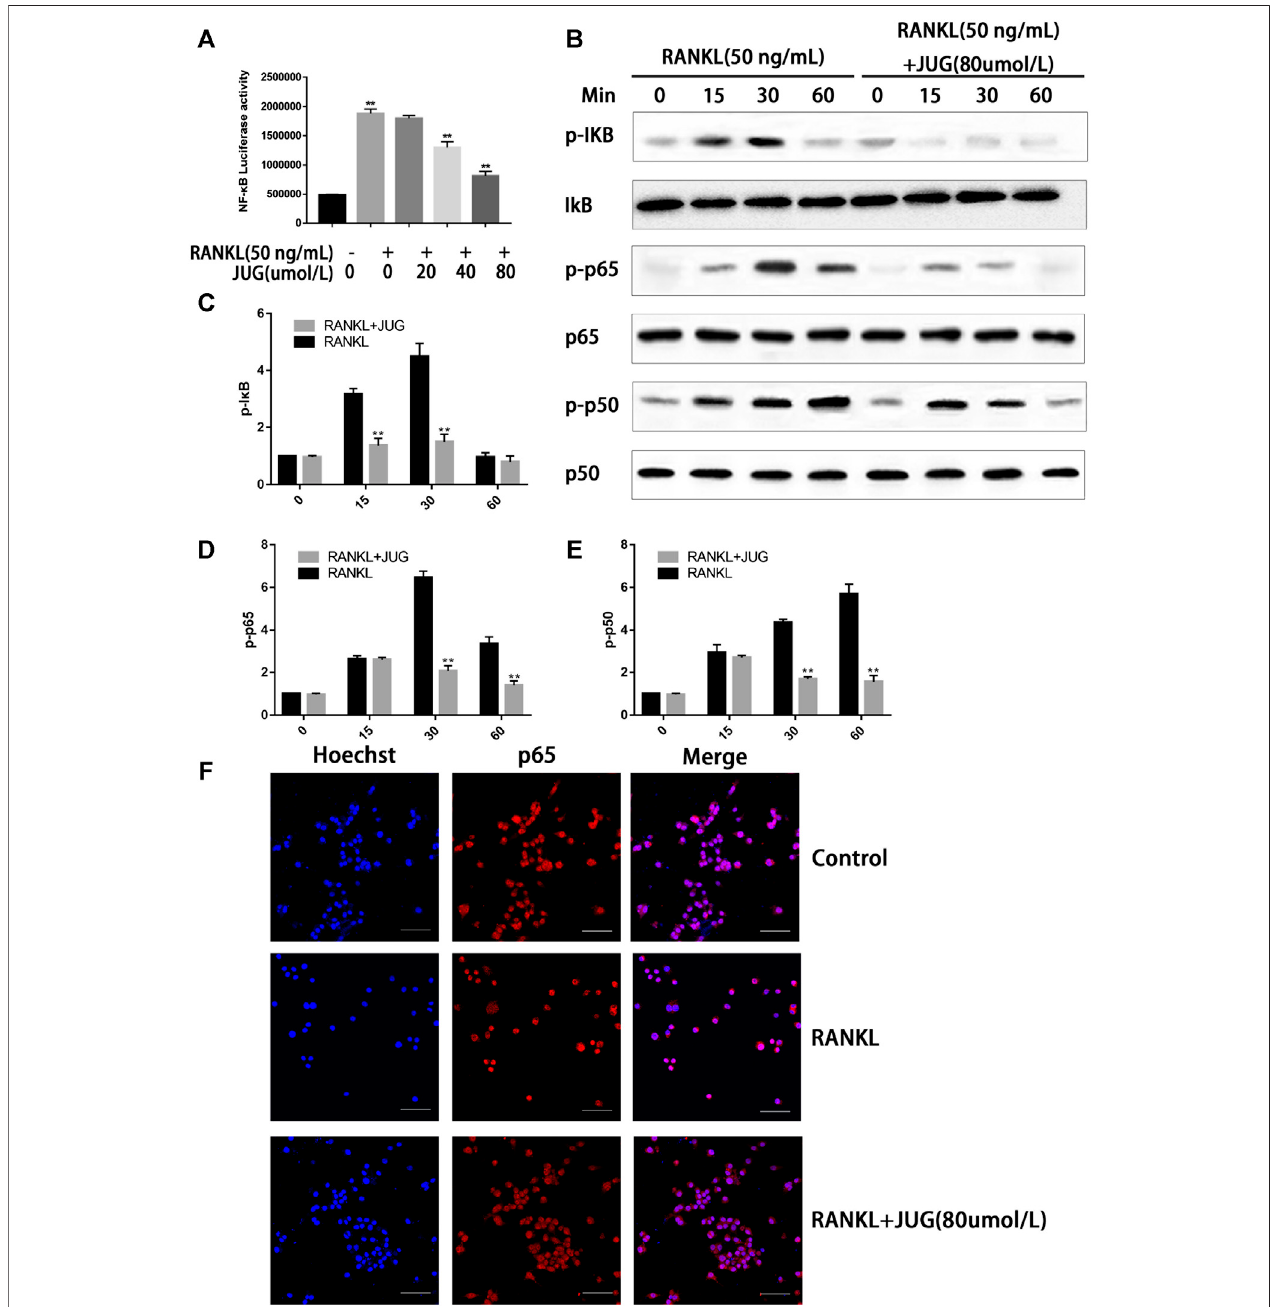
FIGURE 6 | JUG suppresses the NF- κ B signaling pathway. The ratio of the fl uorescence intensity was quanti fi ed by ImageJ software (A) luciferase reporter gene assay showing that JUG suppresses the RANKL-induced transcriptional activity of NF- κ B. (B) Western blot of phosphorylation of I κ B, p65, p50 (D) Representative imageofawesternblotdemonstratingtheeffectofJUGonI κ Bdegradationandphosphorylation ofp65andp50 attheindicatedtimes (F) JUGinhibitsRANKL-induced P65 nuclear translocation. Scale bar 50 μ m. Data are presented as the mean ± SEM, * p < 0.05, ** p < 0.01. n (cid:2) 3